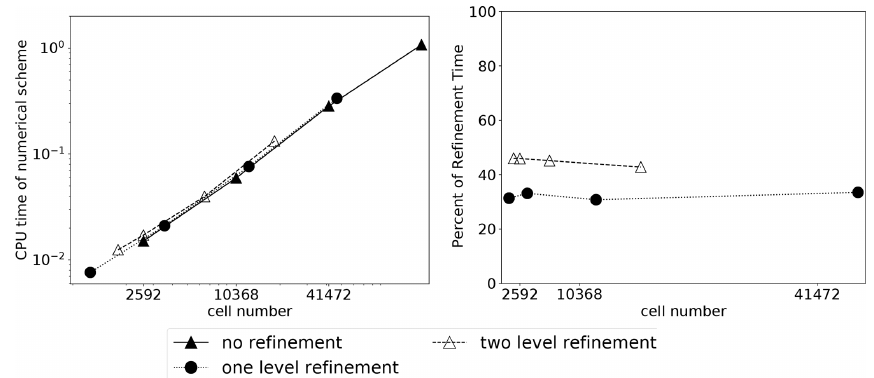
Figure 13. CPU time per time step compared to the cell number. The left figure indicates the CPU time per time step for the transport scheme, while the right figure shows the percentage of the CPU time per time step used for mesh refinement compared to the total CPU